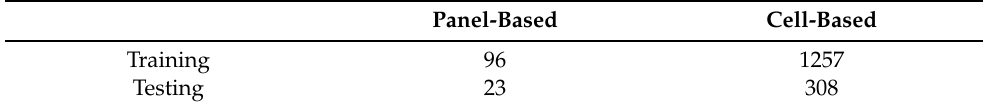
Table 3. The training and testing datasets for panel-based and cell-based defect detection.